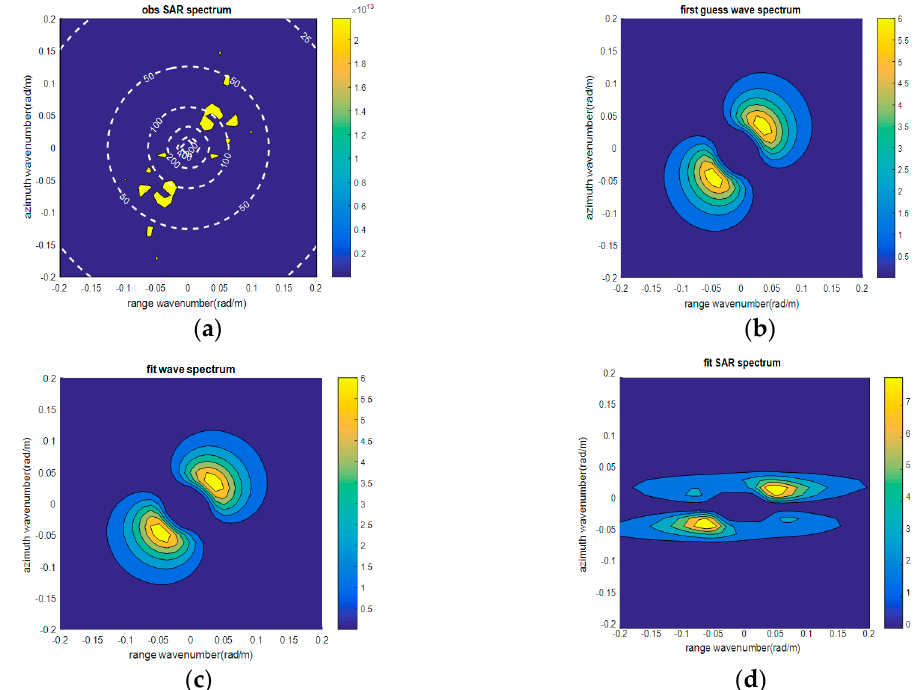
Figure 11. SAR-1 : Max Plank Institute (MPI) algorithm inversion results as follows: ( a ) Observed SAR spectrum (after horizontal flip), ( b ) first guess PM wave spectrum, ( c ) fit PM wave spectrum, and ( d ) fit SAR spectrum.